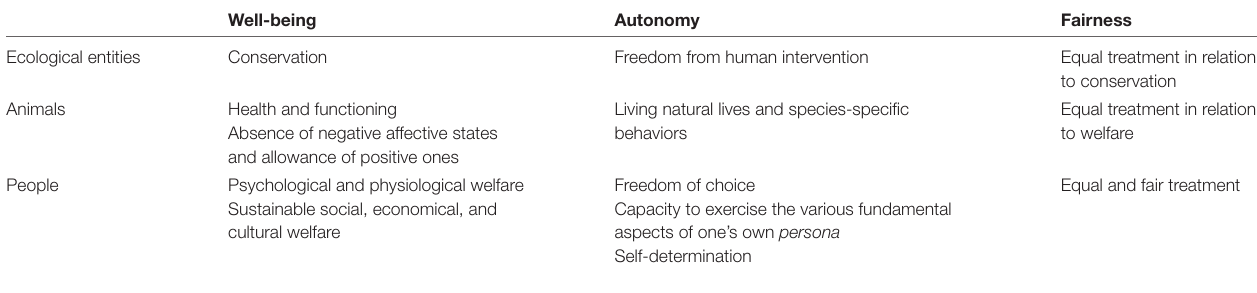
to conservation Equal treatment in relation to welfare